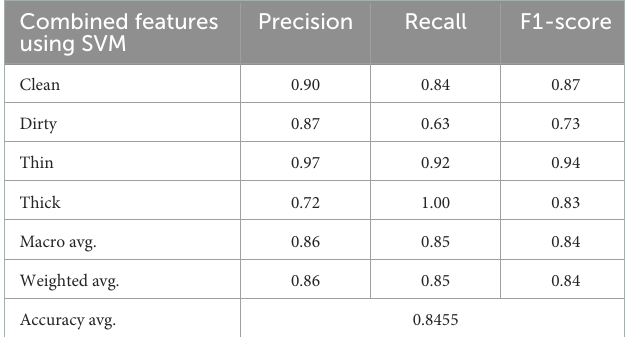
TABLE 4 Precision, recall and F1-score of combined features using